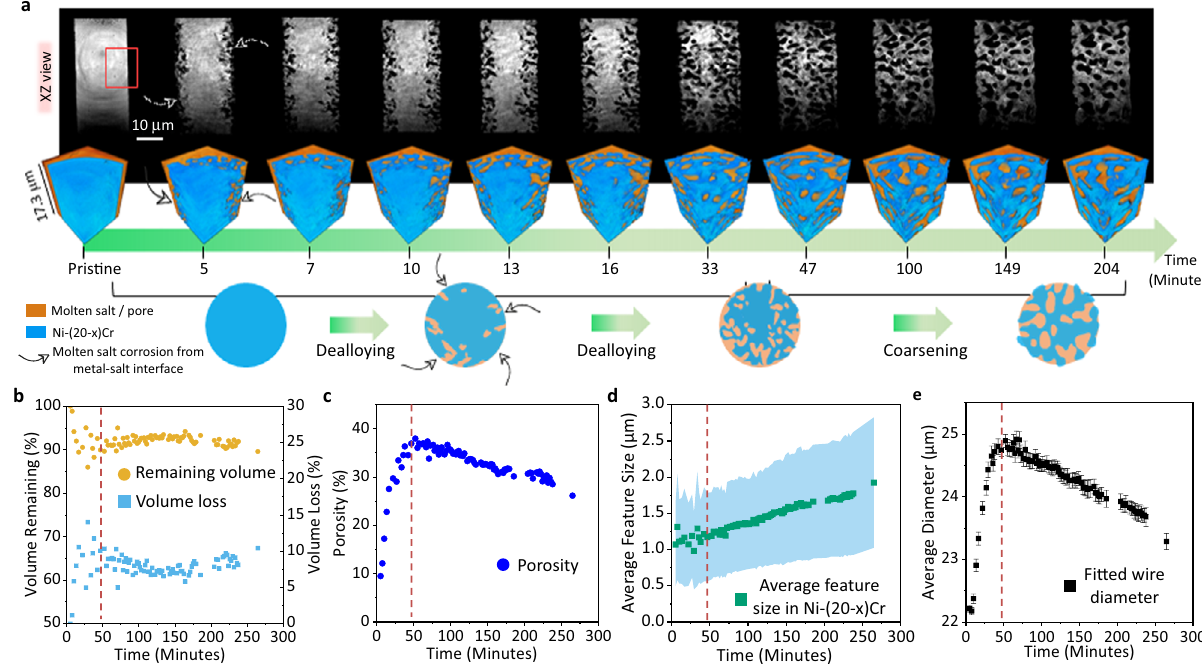
Fig. 2 In situ synchrotron X-ray nano-tomography on Ni – 20Cr reacting with KCl – MgCl 2 molten salt at 800 °C. a Pseudo-2D cross-sectional view ( XY ) of the full microwire and 3D visualization of a volume of interest (marked with a red rectangle) showing the morphological evolution of the Ni – 20Cr microwire. A schematic shows the formation of bicontinuous porous structure during dealloying and the growth of the feature size for pores and ligaments due to coarsening. b – e Quantitative analysis of the 3D morphological characteristics including the remaining volume and loss volume of the solid phase, porosity, average ligament feature size, and fi tted average wire diameter as a function of reaction time at 800 °C. The blue-shaded range in d corresponds to the size distribution of the bicontinuous features. Error bars in e indicate the standard deviation from different pseudo-cross-section